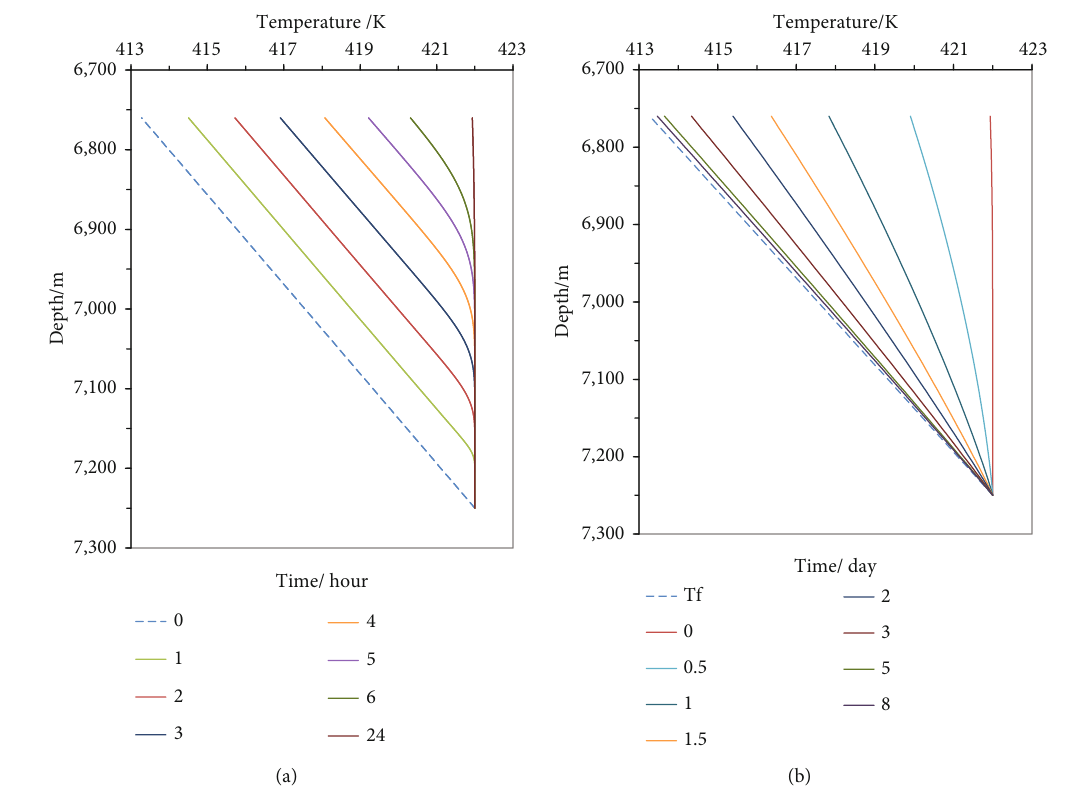
Figure 8: Wellbore temperature distribution at di ff erent times. (a) During production. (b) After